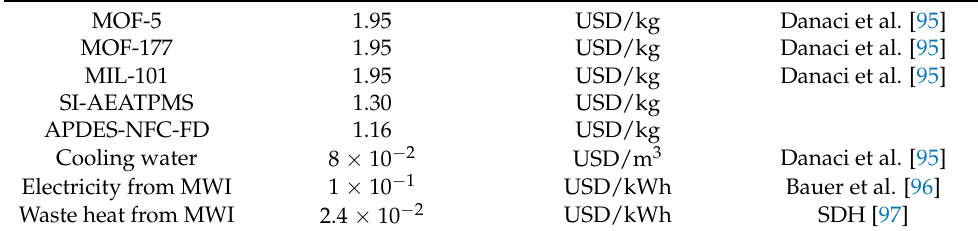
Table 9. Variable operating